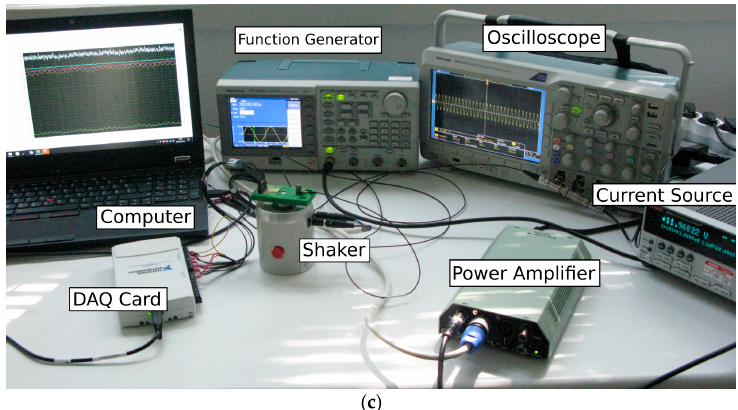
Figure 3. Experimental setup for the characterization of the piezoelectric cantilever arrays: ( a ) Wire bonded cantilever array on the printed circuit board (PCB); ( b ) 3D printed sample holder with a calibrated accelerometer mounted on a shaker; ( c ) the shaker was controlled by a function generator through a power amplifier. The output voltage signals of the cantilevers and the calibrated accelerometer were collected by a programmed data acquisition card (DAQ). The signals were in situ visualized by an oscilloscope during the automatized frequency sweeps. Current source was used to feed the accelerometer.